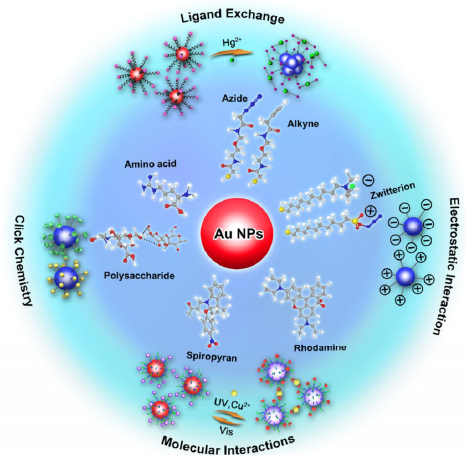
Figure 3. Strategies for functionalization of gold nanoparticles (AuNPs) with small molecules. Reproduced with permission from reference